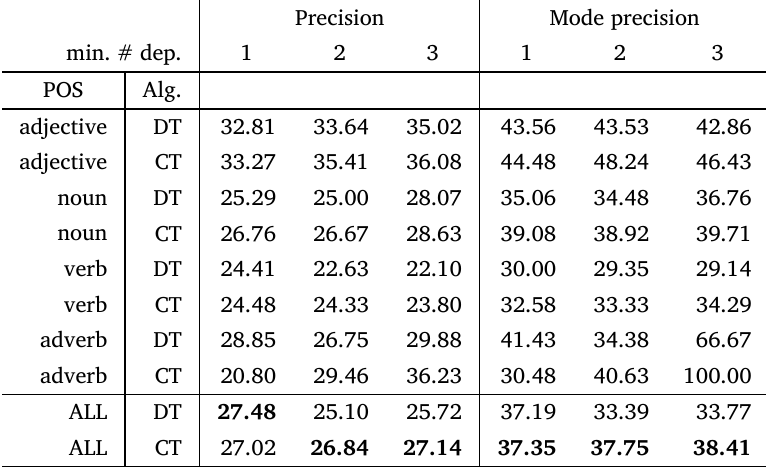
Table 6: Results on the LexSub test dataset for global (DT) and contextualized (CT) similarities, per min number of dependencies to target Precision Mode precision min. #